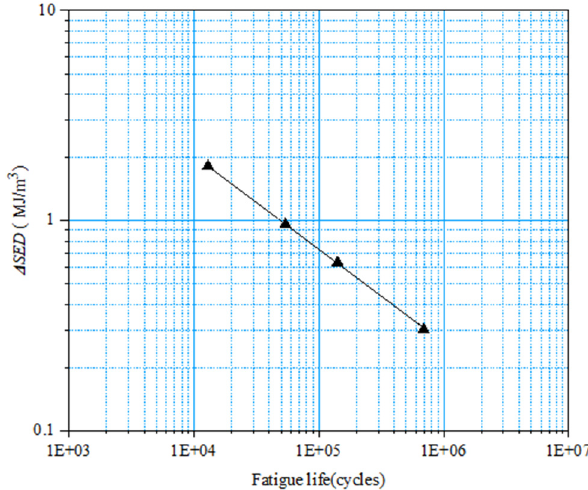
Figure 5. ∆ SED–N f curve of Figure 5. Δ SED–N f curve of carcass.